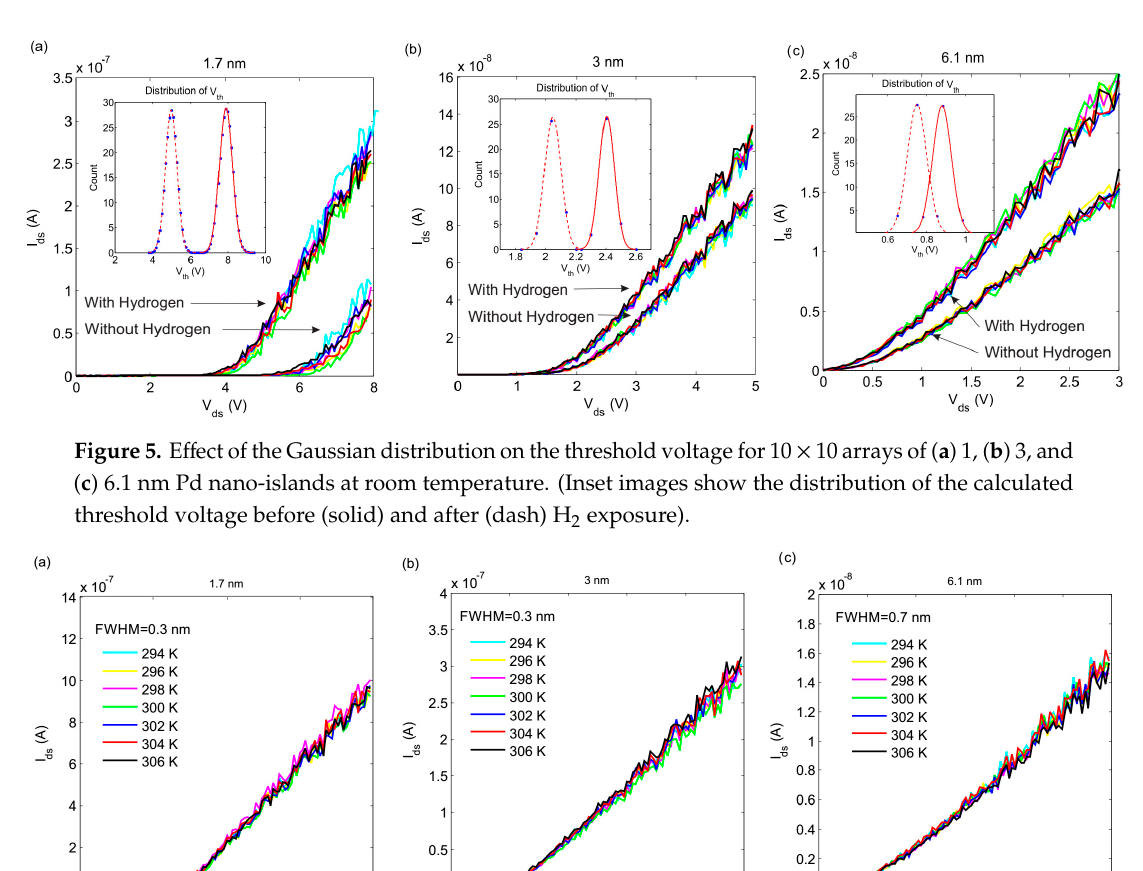
Figure 6. Effect of temperature variation on the Coulomb blockade threshold voltage of arrays for ( a ) b ) 3, and ( c ) 6.1 nm palladium 1.7, ( b ) 3, and ( c ) 6.1 nm palladium nano-islands. 1.7, (